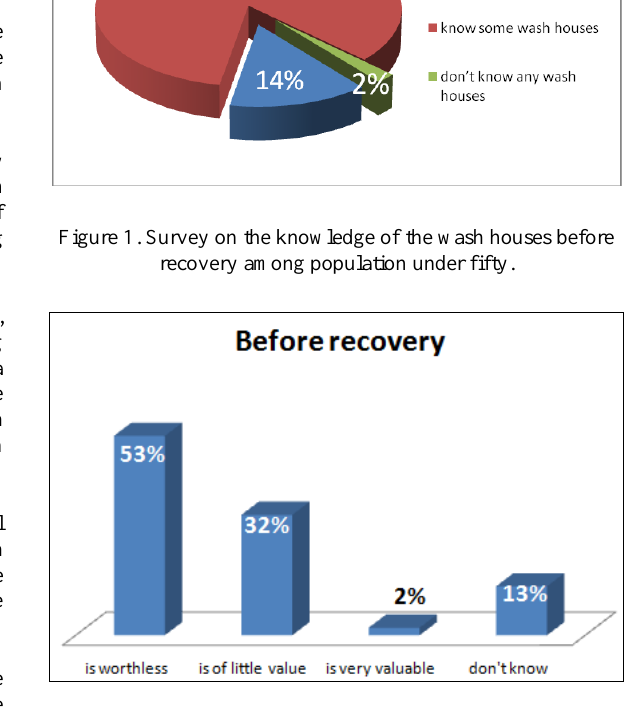
Figure 2. Survey on the attributed value to wash houses before recovery among population under